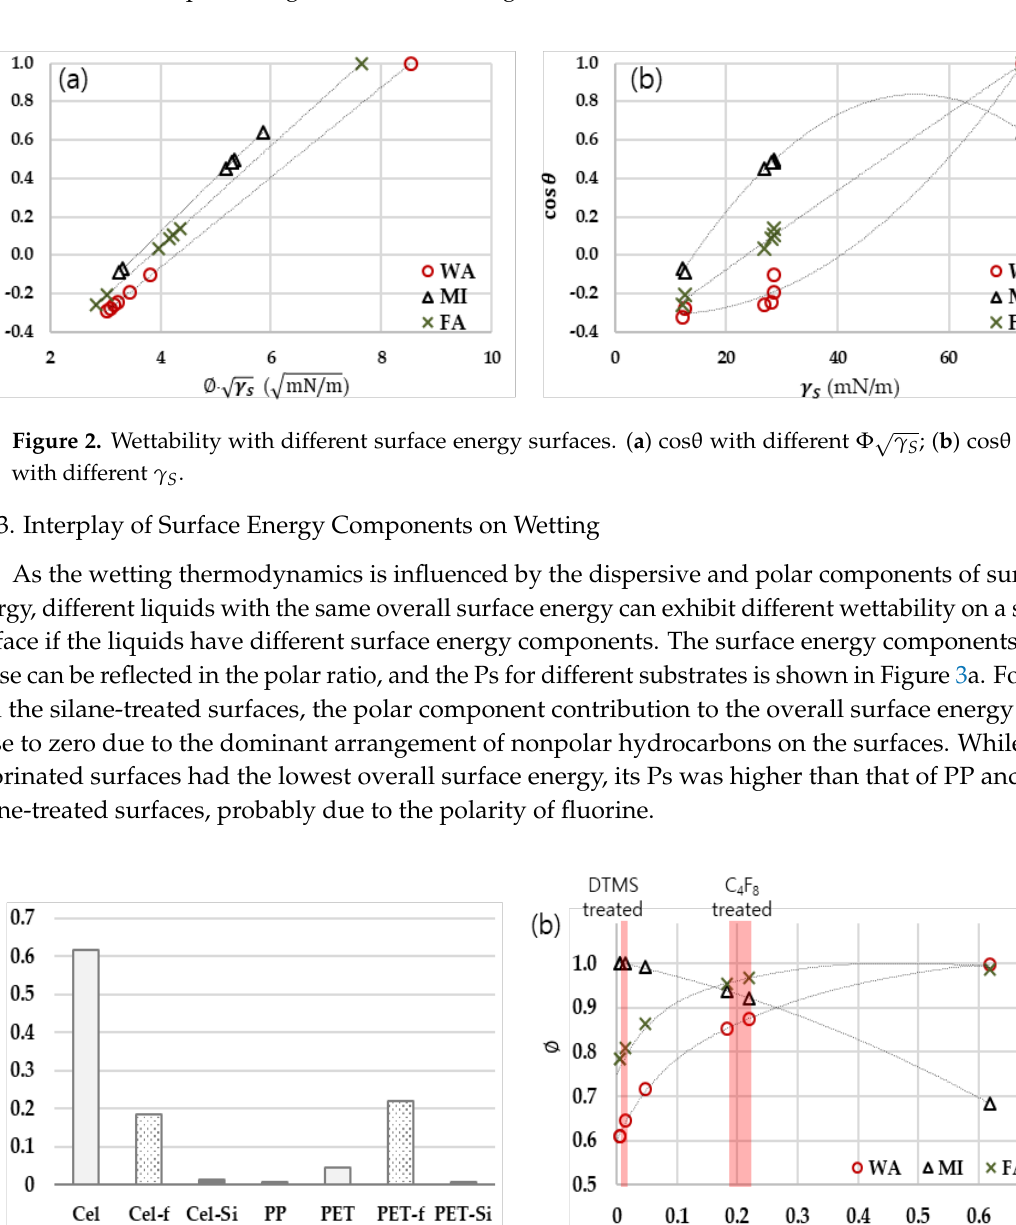
Figure 3. Surface polarity influencing wetting. ( a ) Percentage of the polar contribution to the overall surface energy of solids; ( b ) Interfacial function with % polarity.